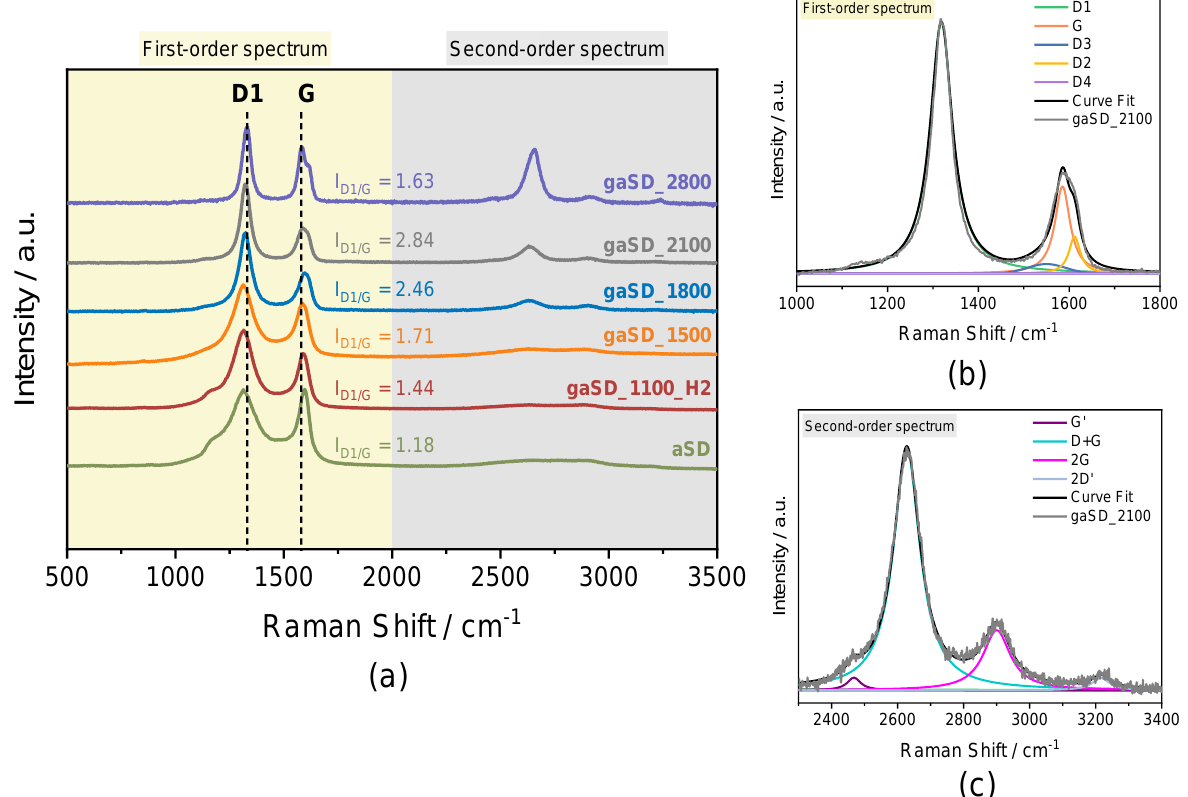
Figure 4. ( a ) Raman spectra of untreated and modified aSD; ( b ) example of curve fitting of first-order Raman spectra and ( c ) example of curve fitting of second − order Raman spectra. Fitting parameters based on literature [33 – 37] .